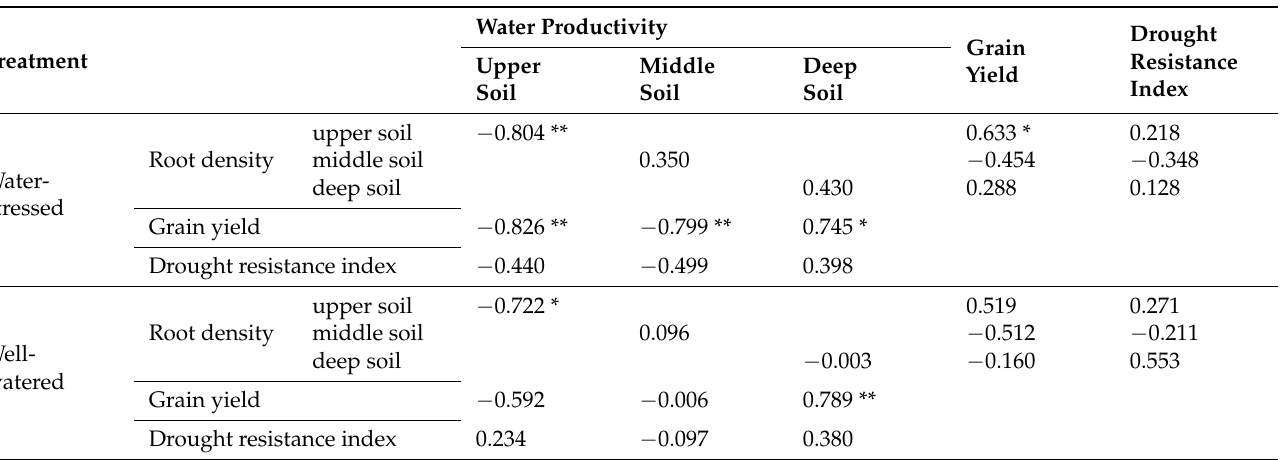
Table 4. Correlation analysis of root density with water productivity and grain yield for foxtail millet varieties grown under two treatments in 2019 and